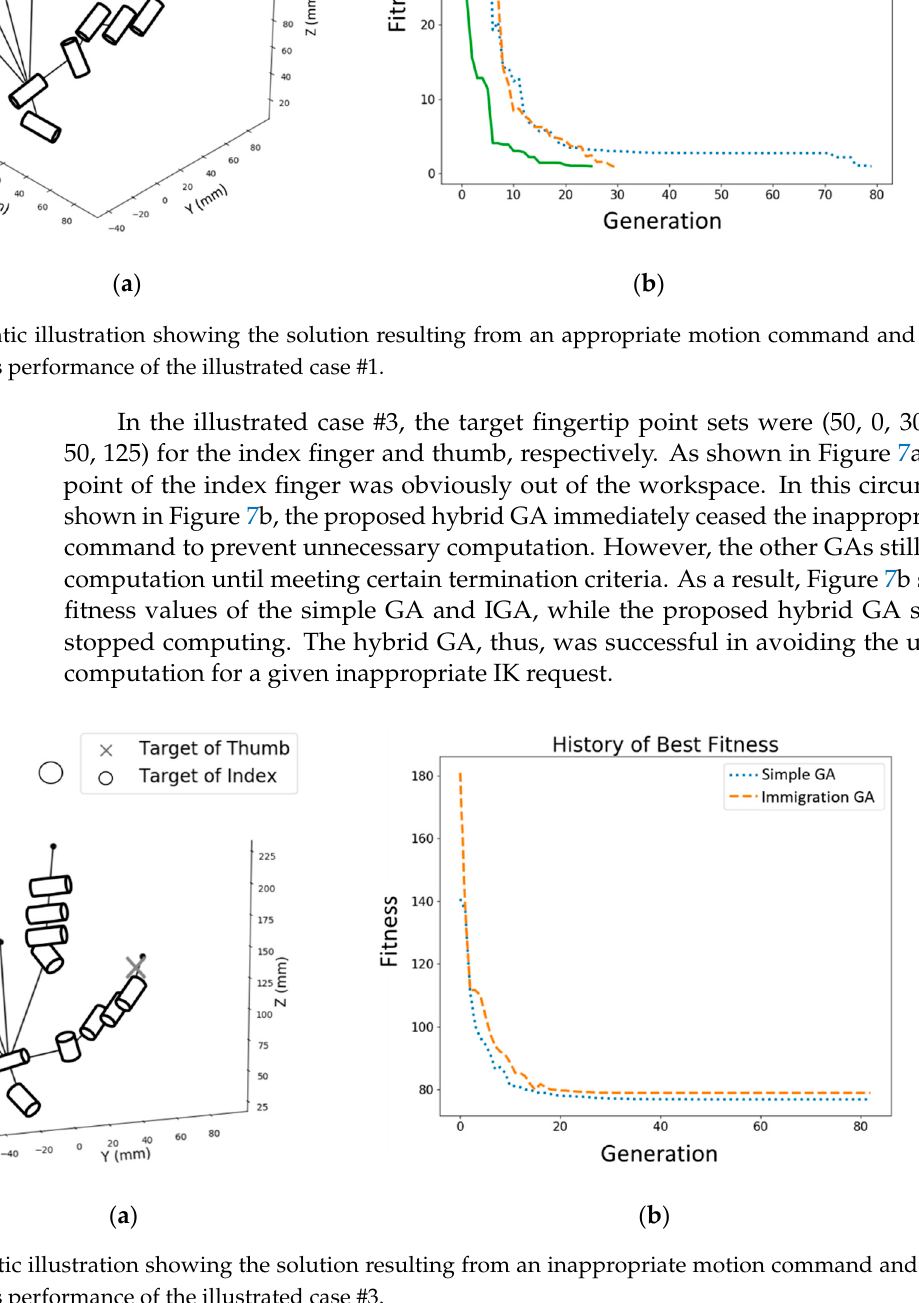
Figure 7. ( a ) Schematic illustration showing the solution resulting from an inappropriate motion command and ( b ) the corresponding fitness performance of the illustrated case #3.